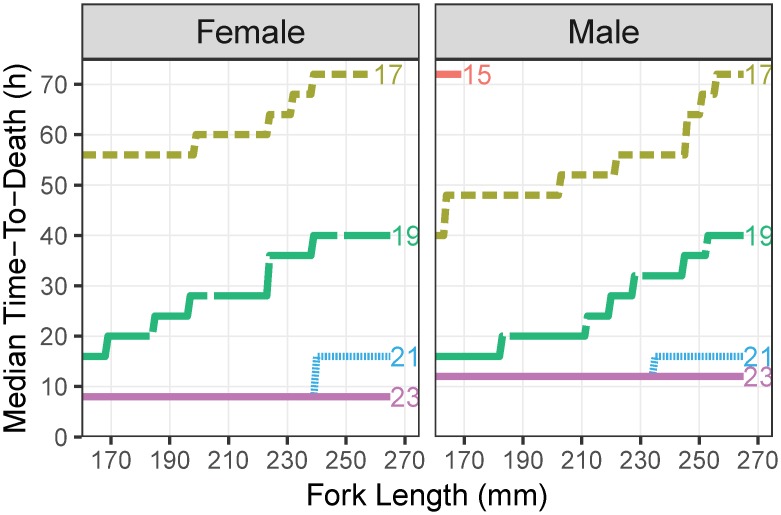
Median time-to-death (h) for male and female blue catfish at various salinities predicted by the stratified Cox proportional hazards model.Numbers at the end of the lines represent salinities in practical salinity units (psu). Figure available in color online.